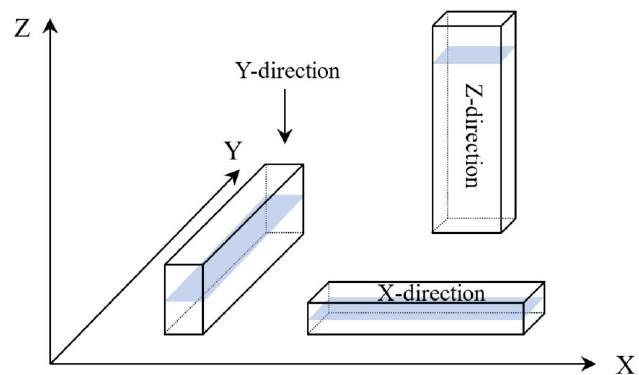
Figure 1. Build Figure 1. Build orientation.